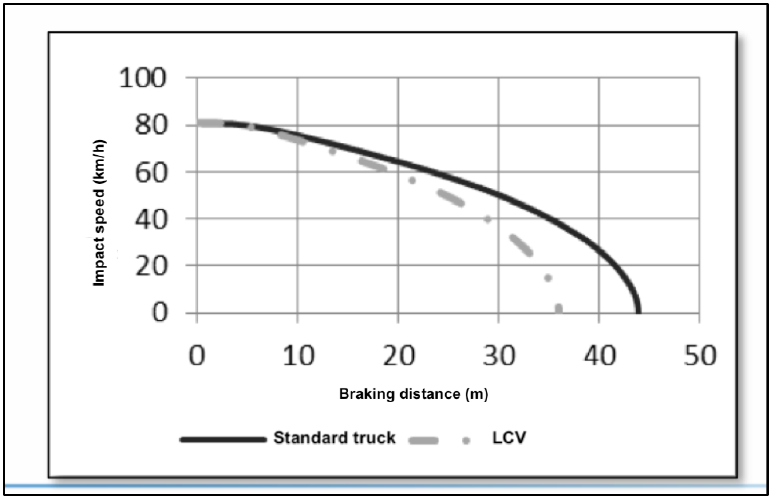
Figure 1. Braking comparison of a standard truck and a long combination vehicle. Both trucks start braking at full force at 80 km/h. The graphs show the impact speed as a function of the braking distance